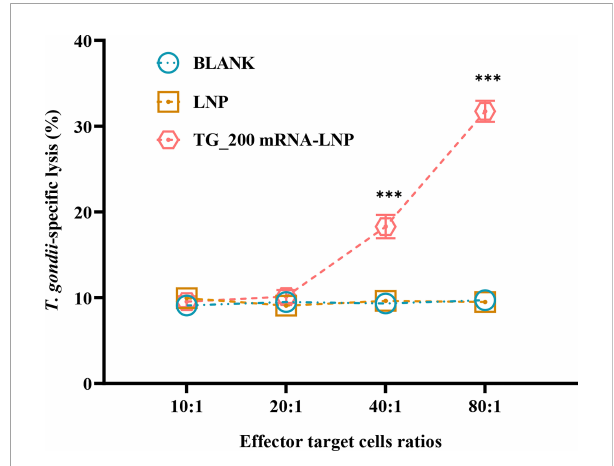
FIGURE 6 CTL activities of spleen lymphocytes in TG_200 mRNA-LNP immunized mice. The vertical axis shows T. gondii -speci fi c lysis as a percentage of the total possible lysis (%). The horizontal axis is the ratio of effector cells to target cells. n = 5/group, *** P < 0.001.